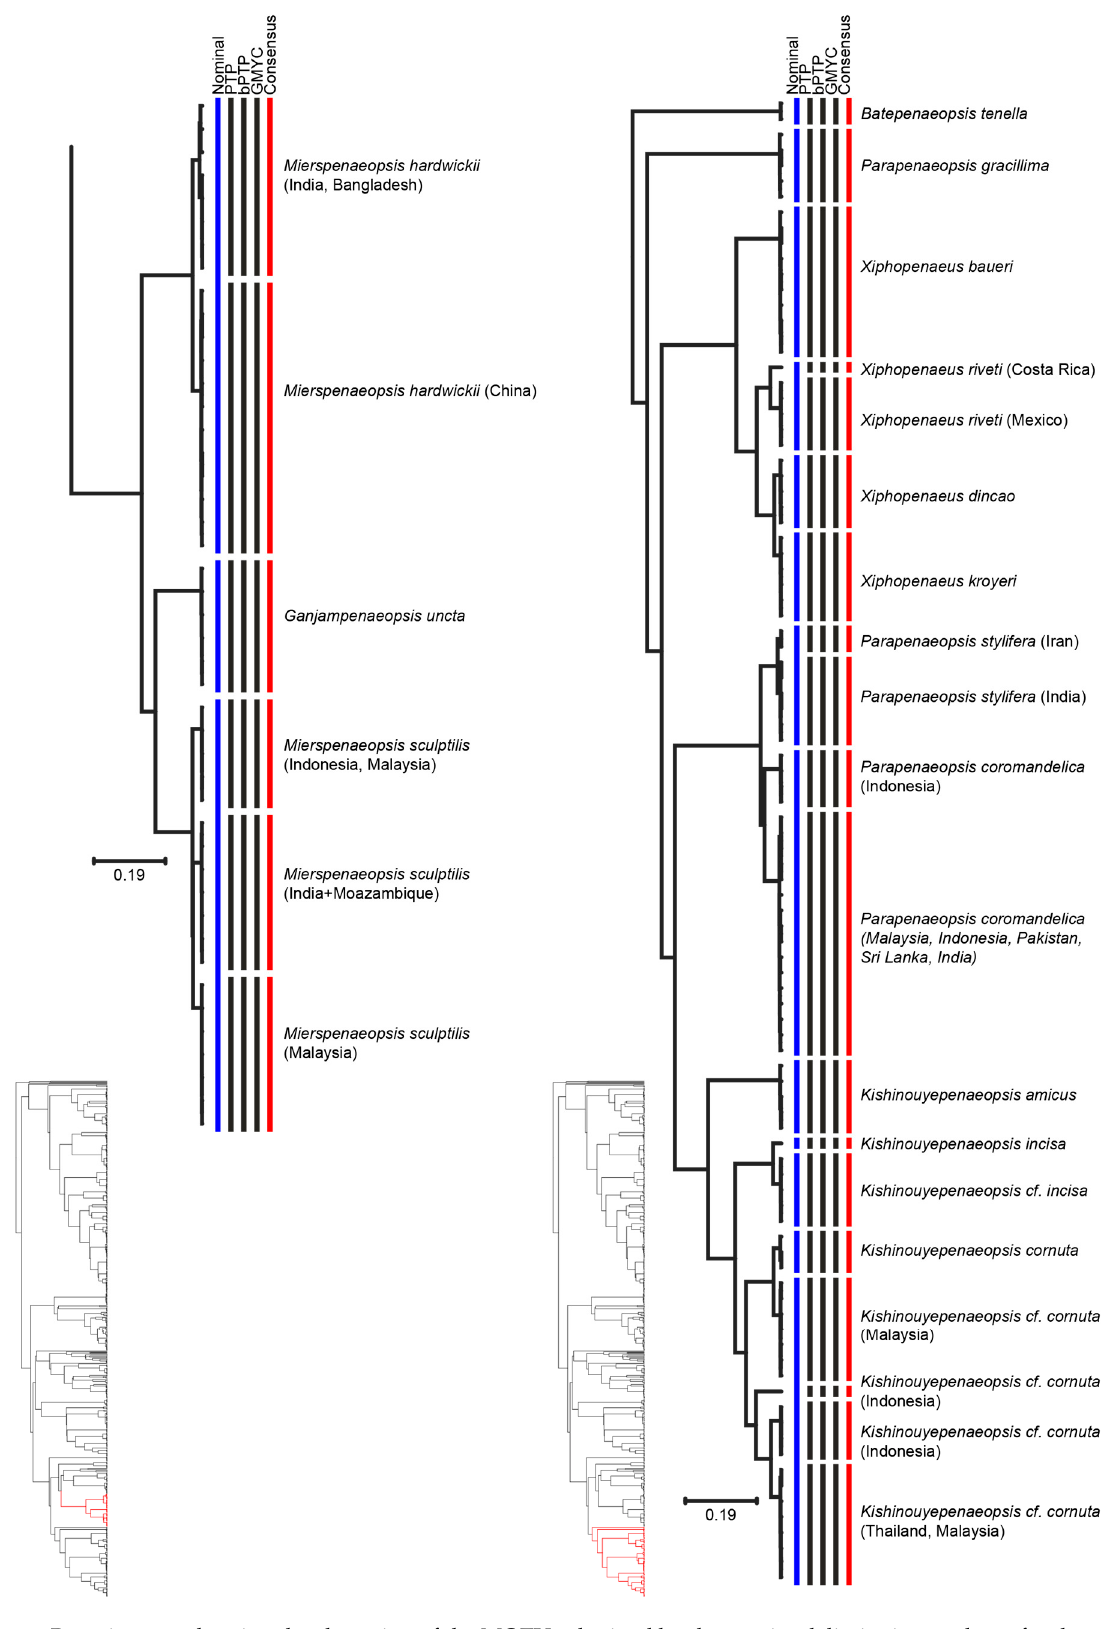
Figure 5. Bayesian tree showing the clustering of the MOTUs obtained by the species delimitation analyses for the genera Batepenaeopsis , Ganjampenaeopsis , Mierspenaeopsis , Kishinouyepenaeopsis , Xiphopenaeus , and Parapenaeopsis .